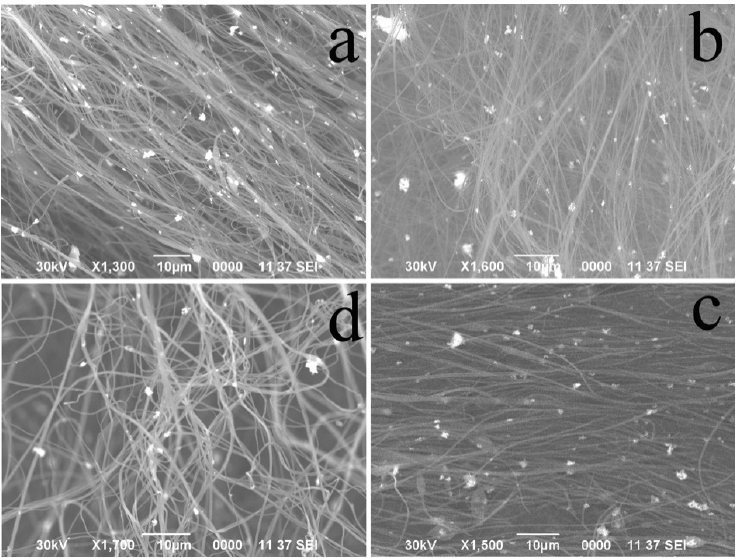
Figure 1. SEM images of non-calcined polymer fibers based on SrTiO 3 /PAN ( a ) and their composites with metal oxide particles: SrTiO 3 /PAN/Fe 2 O 3 ( b ), SrTiO 3 /PAN/Cr 2 O 3 ( c ), and SrTiO 3 /PAN/CuO ( d ) . The inclusion of metal oxides does not cause a corresponding change in the fiber diameter. On